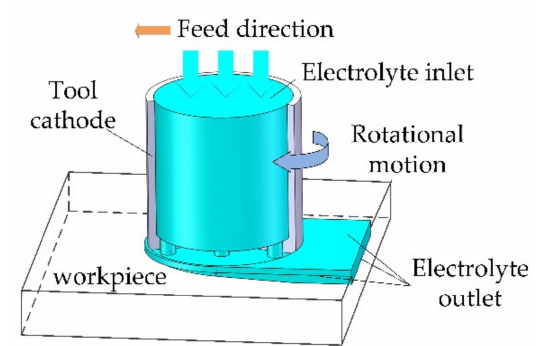
Figure 2. Schematic of electrolyte